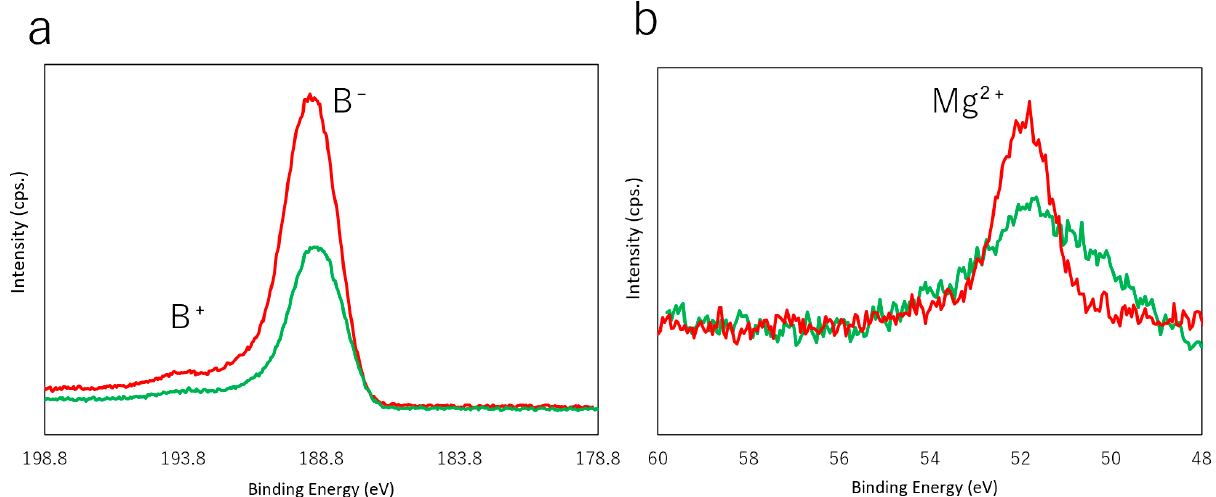
Figure 2. HAXPES spectra of B 1s ( a ) and Mg 2p ( b ) core-levels for the MgB 2 film before (red) and after (green) ion-exchange treatment using resin.